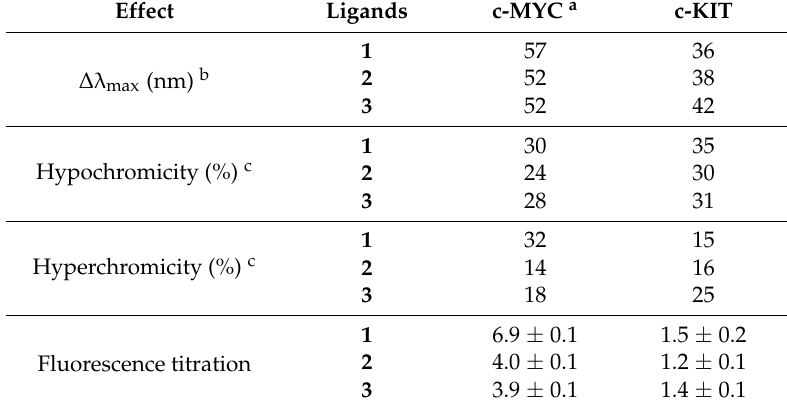
Table 4. Spectral effects and parameters for the interaction of ligands 1 , 2 and 3 with c-MYC and c-KIT 1 G-quadruplexes determined using Benesi-Hildebrand method and data from fluorescence titration experiments (K b —binding constant, n —number of bound ligand molecules per G-quadruplex).